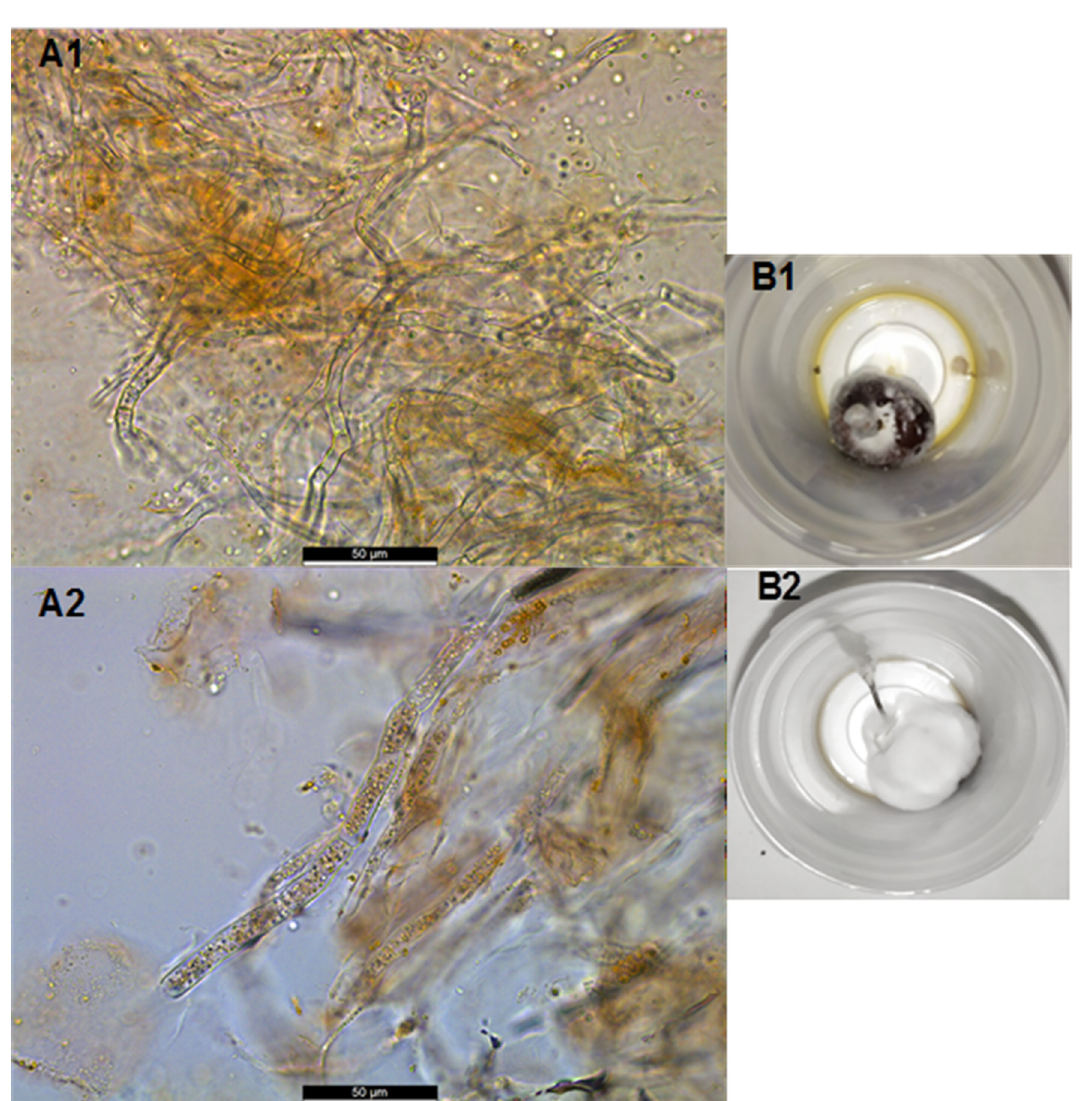
Figure 3. Fungal hyphae present in the flesh of ‘California’ ( A1 ) and ‘Burlat’ ( A2 ) cultivars ( Prunus avium L.). Final symptoms of cherries affected by symptoms of ‘aqueous spot’, total coverage of white mycelium ( B1 ) and grey mycelium ( B2 ) after six days stored in sterile plastic bottles at 25 °C.